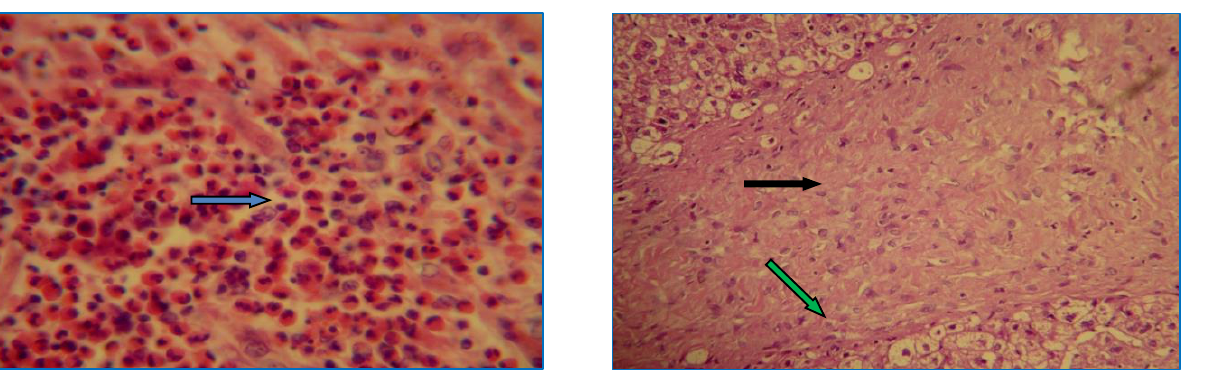
Figure, 5: G2: Liver of rabbit at 20 days post infection show infiltration of large numbers of eosinophils within the hepatic parenchyma ( ) (H and E 40x).